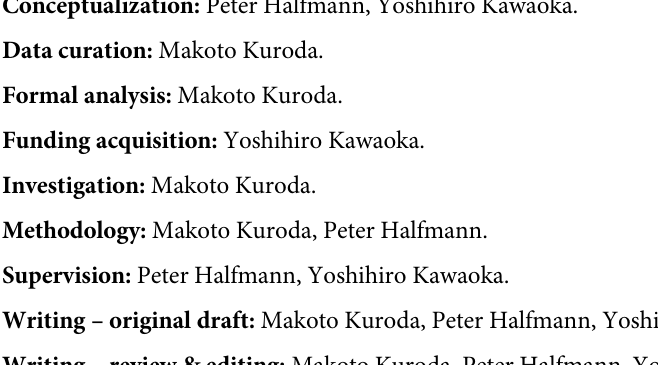
S11 Fig. Phosphorylation level of MERTK during EBOV entry. The phosphorylation level of MERTK in Huh7.0 cells overexpressing MERTK. Cells were transfected with an expression vector for MERTK for 24 h and then infected with EBOV Δ VP30 at an MOI of 3.0 for 30 min. Cell lysates were immunoprecipitated with an anti-MERTK antibody and then immuno- blotted. Data are representative of two independent experiments. IP, immunoprecipitation. WCE, whole-cell extract.